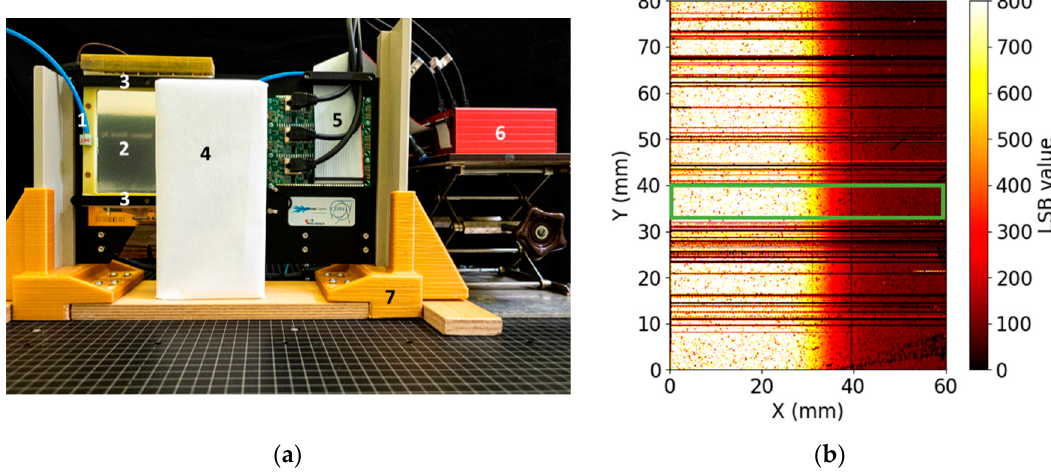
Figure 5. ( a ) The LaGEMPix with a 2.5 cm thick lead block placed in front of the detector: (1) gas outlet; (2) the 100 × 100 mm 2 triple-GEM stack coupled to the optical readout with the thin Mylar window on top; (3) 3D-printed braces to hold together the triple-GEM detector and the image sensor; (4) lead block; (5) cables to connect the detector to the readout system; (6) FPGA module; (7) custom-made support. ( b ) Heat map of the imager after irradiation with 40 kV X-rays.